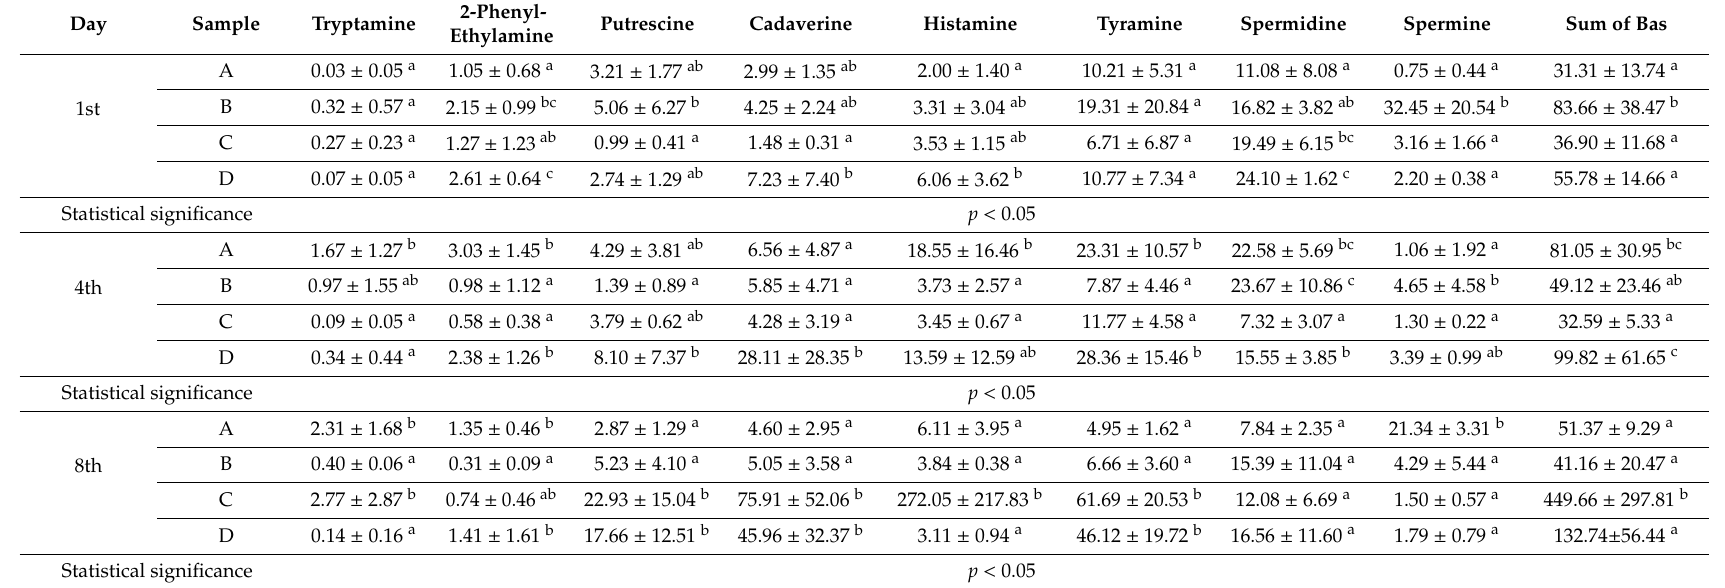
Table 2. Qualitative and quantitative biogenic amine spectrum (in mg · kg − 1 ) for groups (A, B, C, D) depending on the sampling